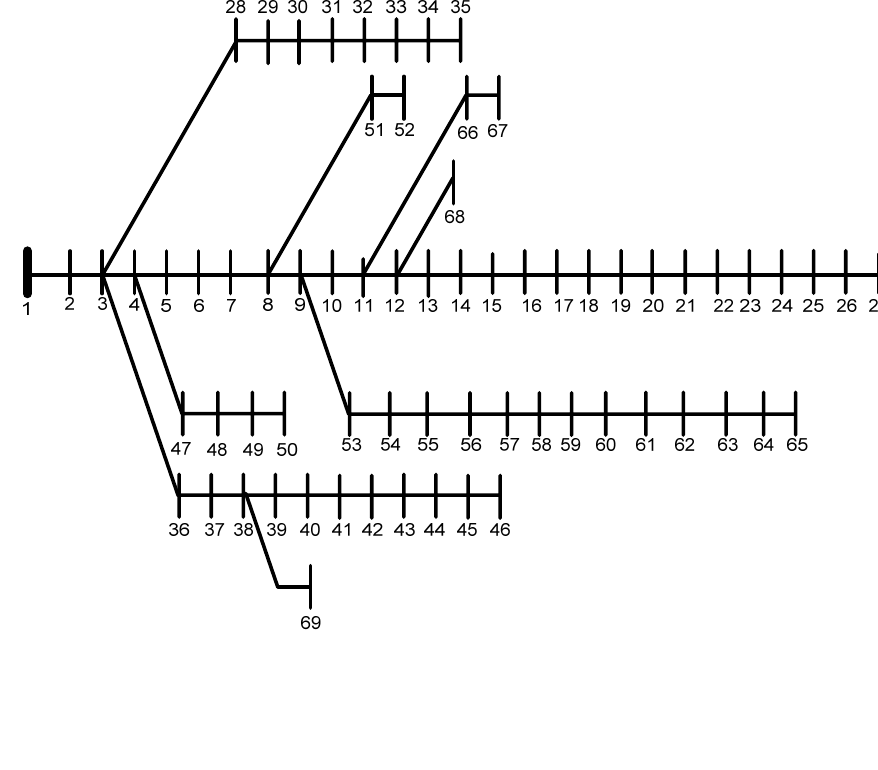
Figure 2. Single line diagram of distribution test